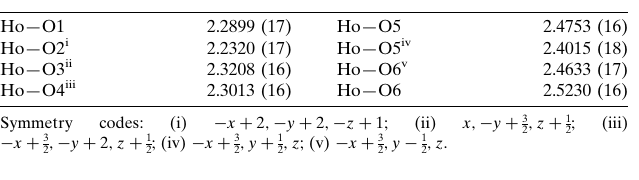
Selected bond lengths (A˚